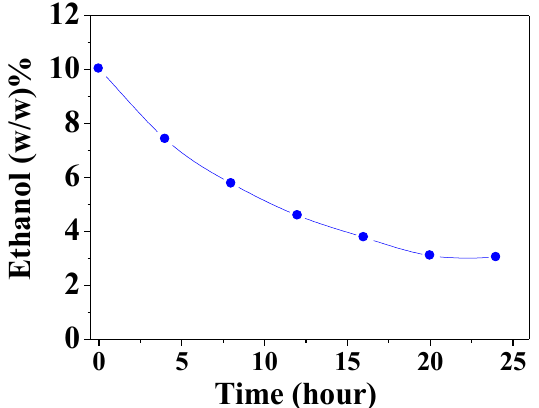
Figure 6. Liquid-phase separation of an ethanol–water solution with a superhydrophobic HiPAS membrane (SO disc). Ethanol concentration in the re-circulated feed stream as a function of time.